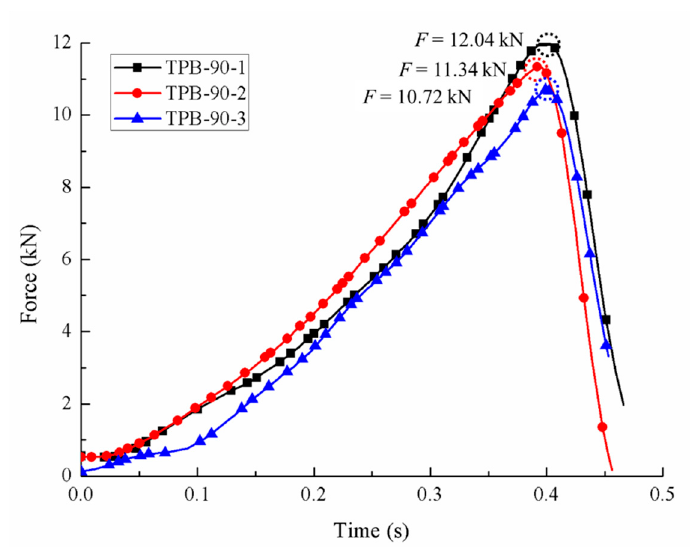
Figure 7. Force -time curves with the loading velocity of 90 mm/min.